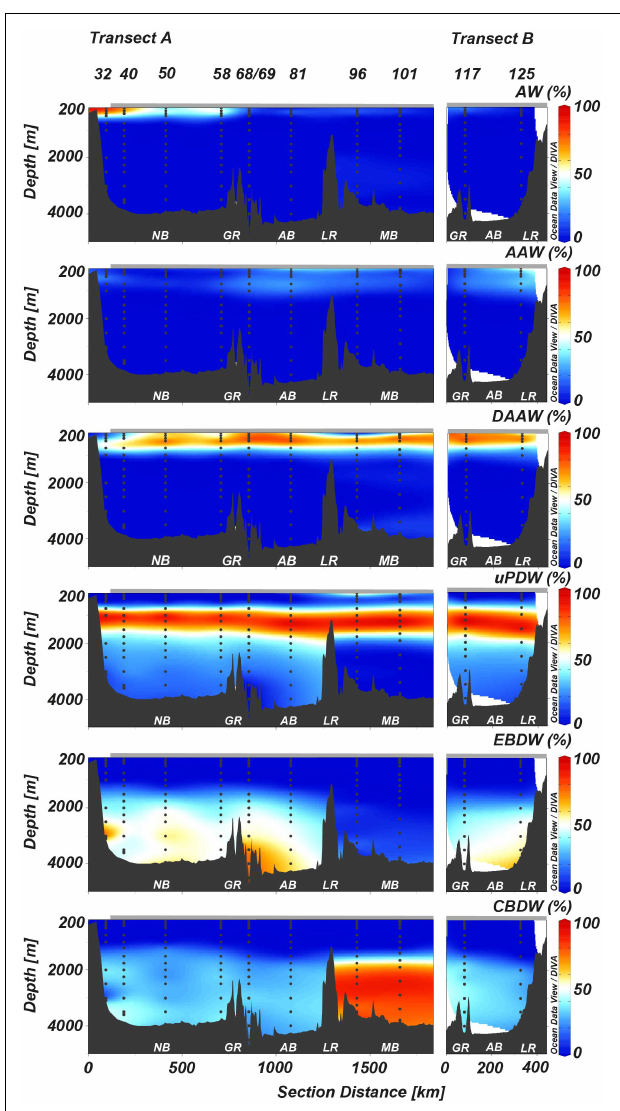
FIGURE 3 | Distribution of water masses based on OMP analysis within the studied section. (A) Longer transect and (B) shorter transect (see Figure 1 for reference). Arrow on map figure defines the direction of the sections shown here. Gray bar on top of the sections represents sea ice extent. See Figure 2 for water masses abbreviations. See Figure 1 for basins abbreviations. LR, Lomonosov